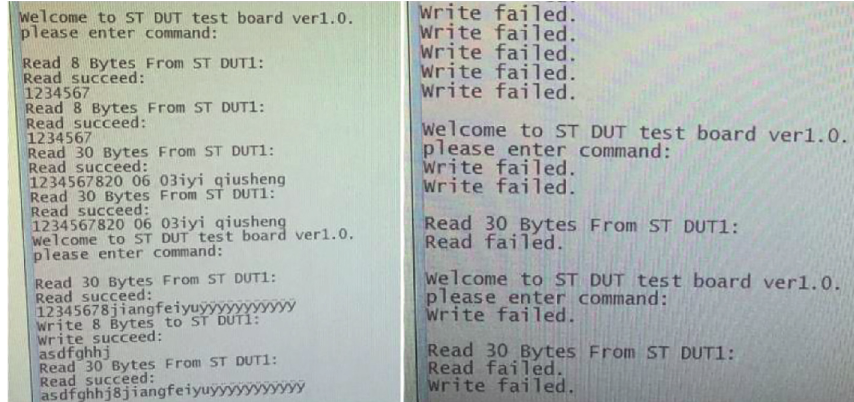
Figure 12: Changes of memory function of read-write before and after the